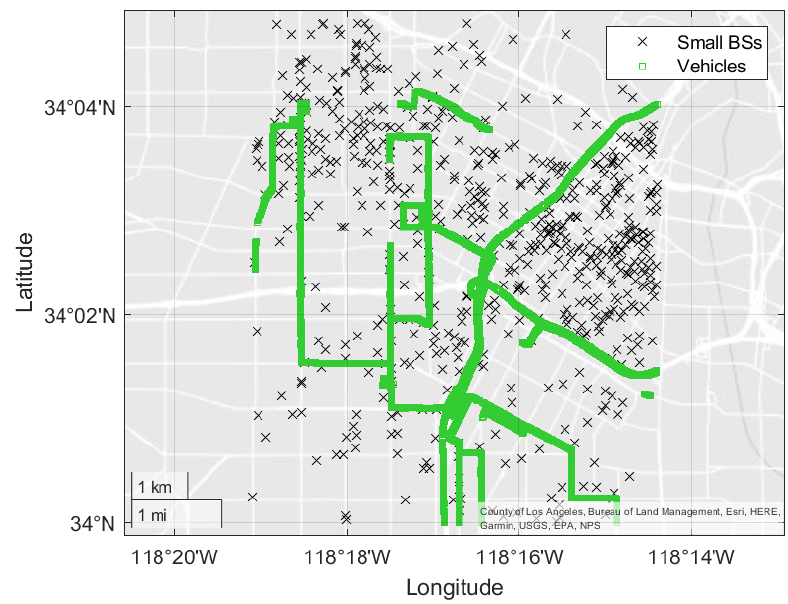
Figure 3. The system model in the city of Los